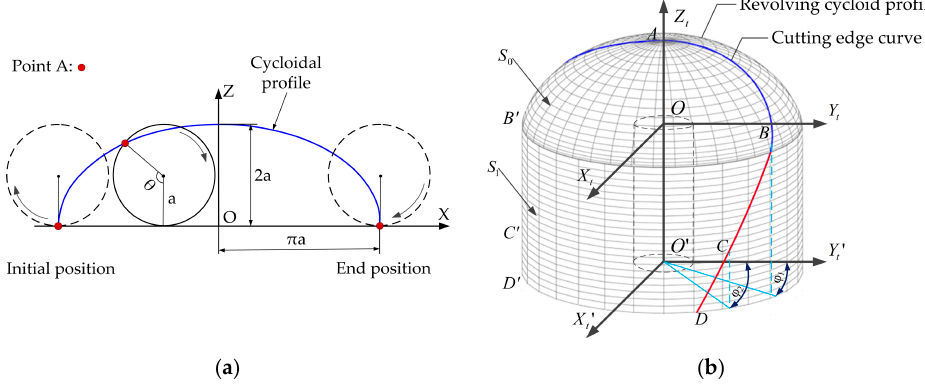
Figure 1. Geometric model of a revolving cycloid milling cutter: ( a ) The forming principle of a cycloid; ( b ) contour surface and cutting edge curve of a revolving cycloid milling cutter.